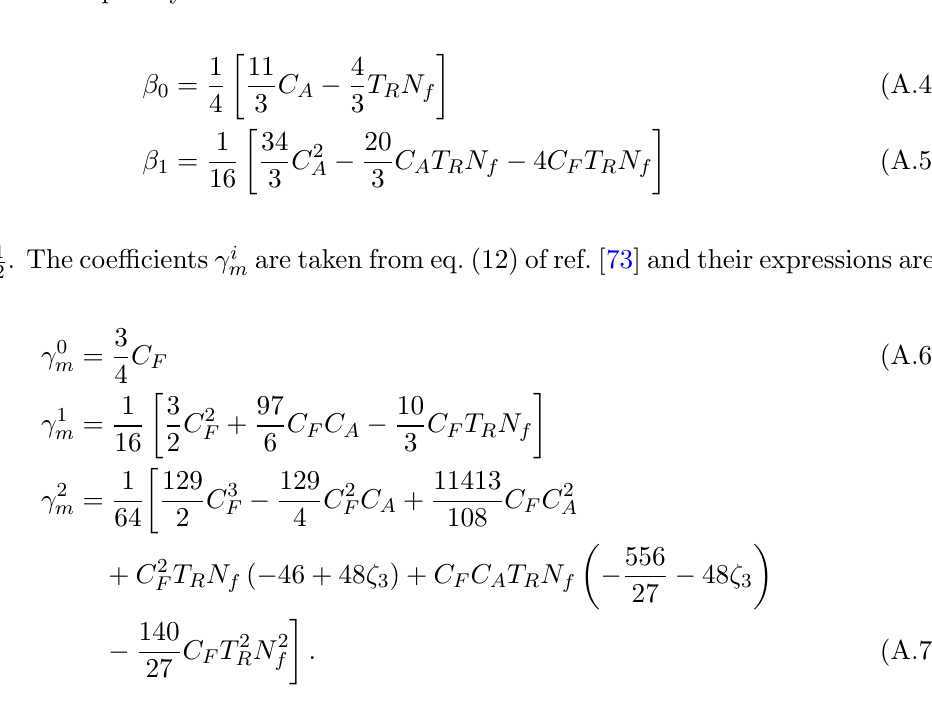
2 = N , C = N , and N c (cid:0) 1 c A F 2 N c